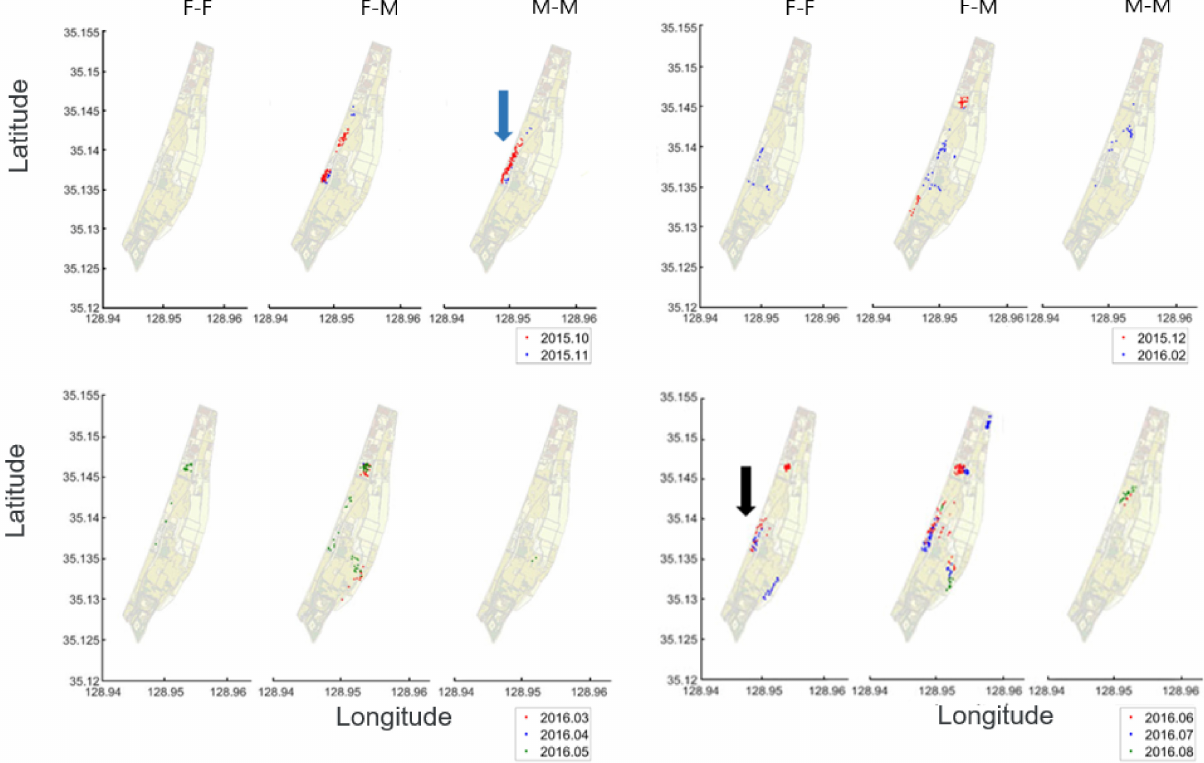
Figure 9. Locations of two individual co-occurrences within 250 m distance in the Macdo wetland during the survey period (October 2015–September